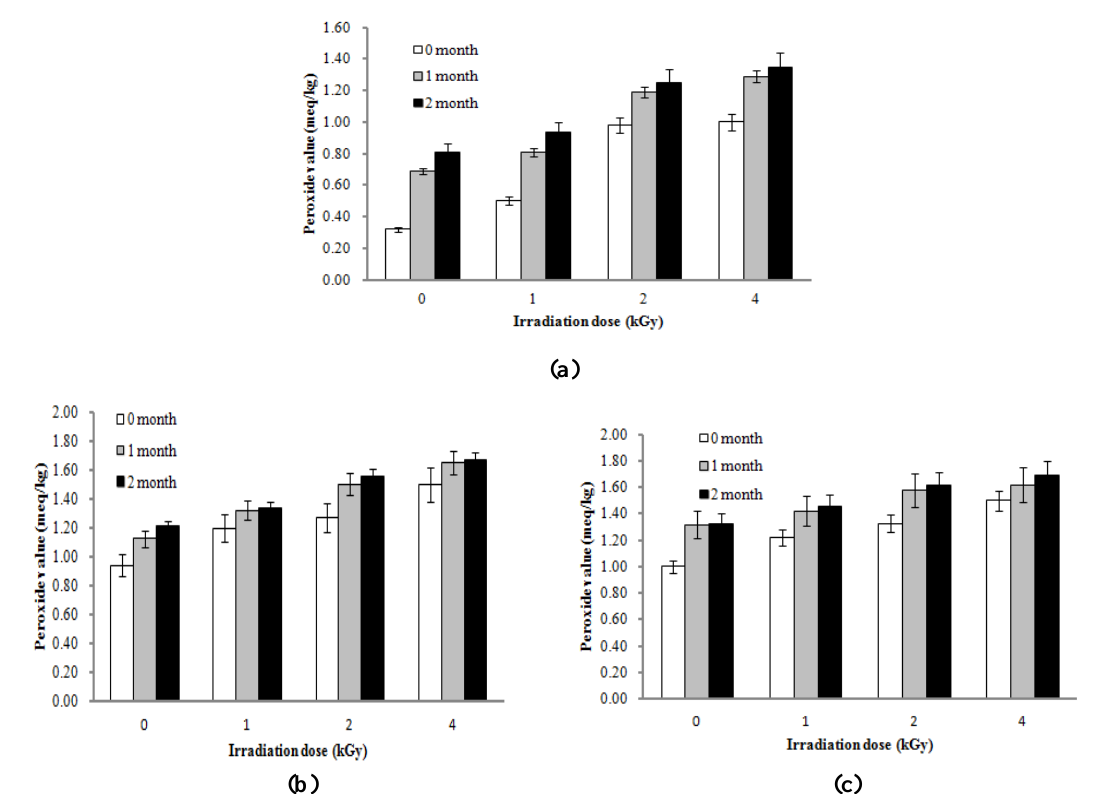
Figure 1. Effect of leek extracts ((a) 0%, (b) 0.5%, (c) 1.0%) on peroxide value (meq/kg) of the electron beam-irradiated pork jerky during storage at 25 